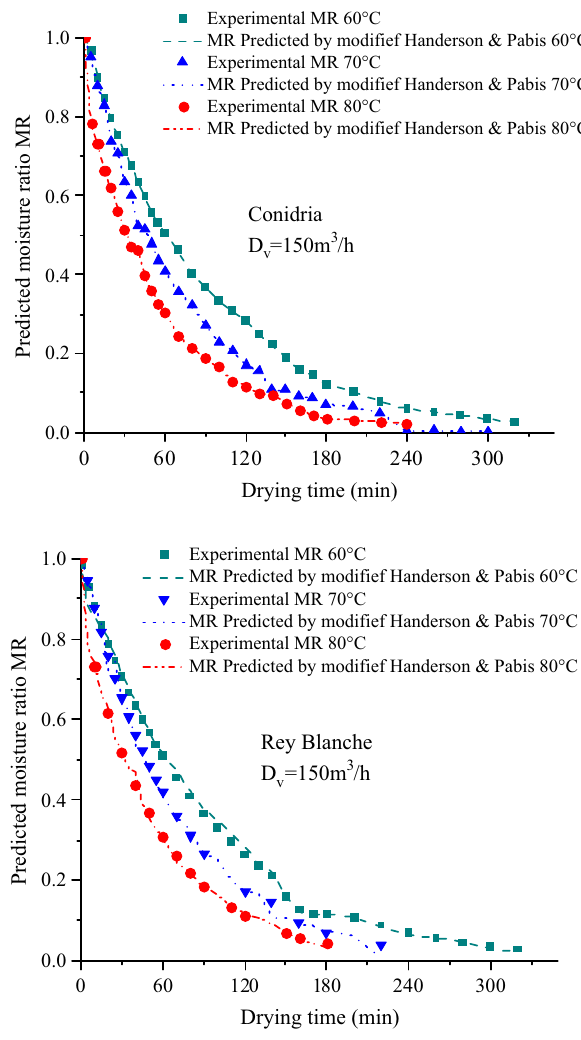
Figure 10. Experimental data of moisture ratio versus drying time fitted with modified Handerson and Pabis model at Dv = 150